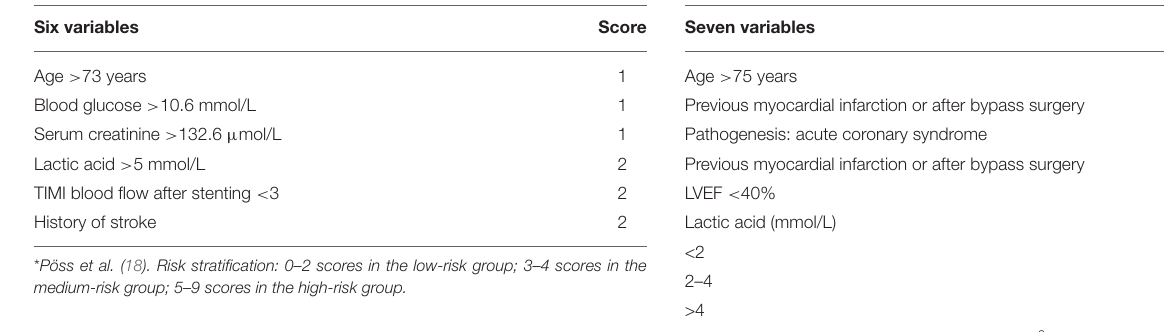
TABLE 1 | Catalog of IABP-SHOCK II score. TABLE 2 | Catalog of CardShock